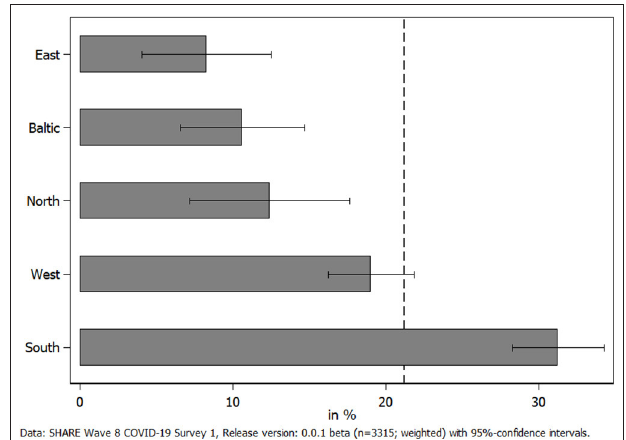
FIGURE 5 | Percent of care recipients facing difficulties in receiving home care since the outbreak of the